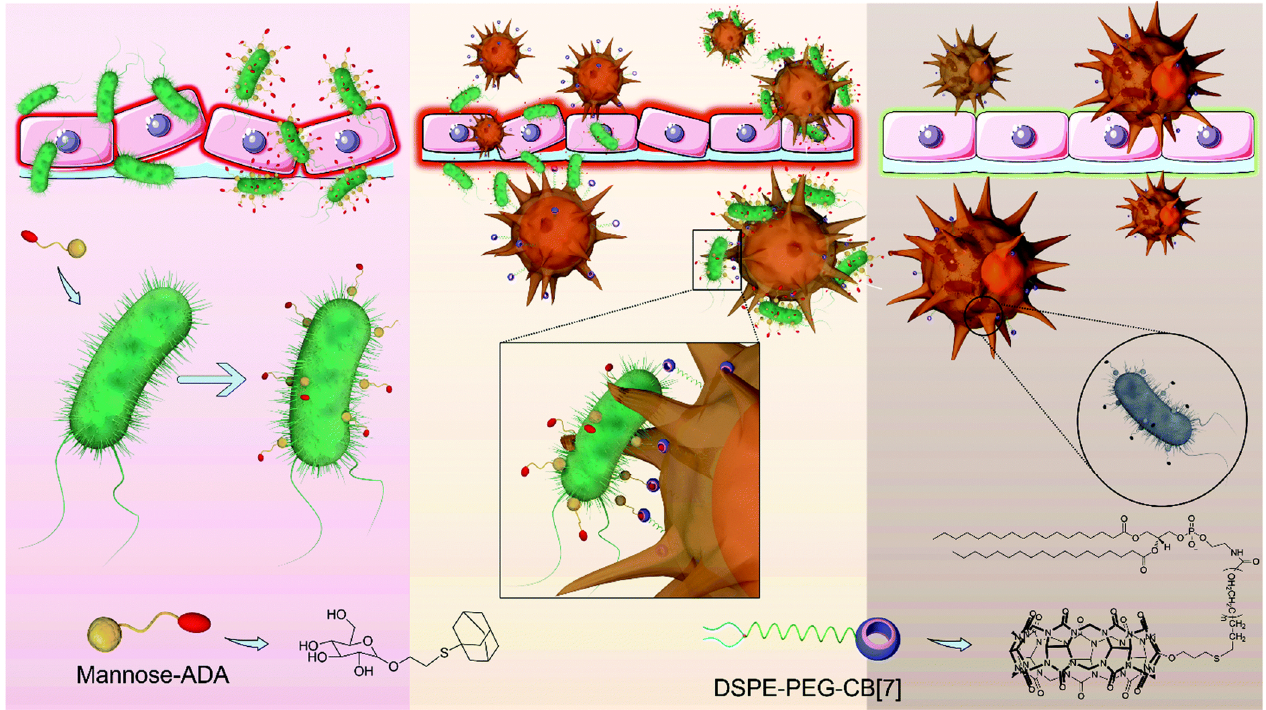
Figure 13. Enhanced antibacterial function of a supramolecular artificial receptor-modified macro- phage. Reprinted with permission from Ref. [108]. Copyright 2022 Royal Society of